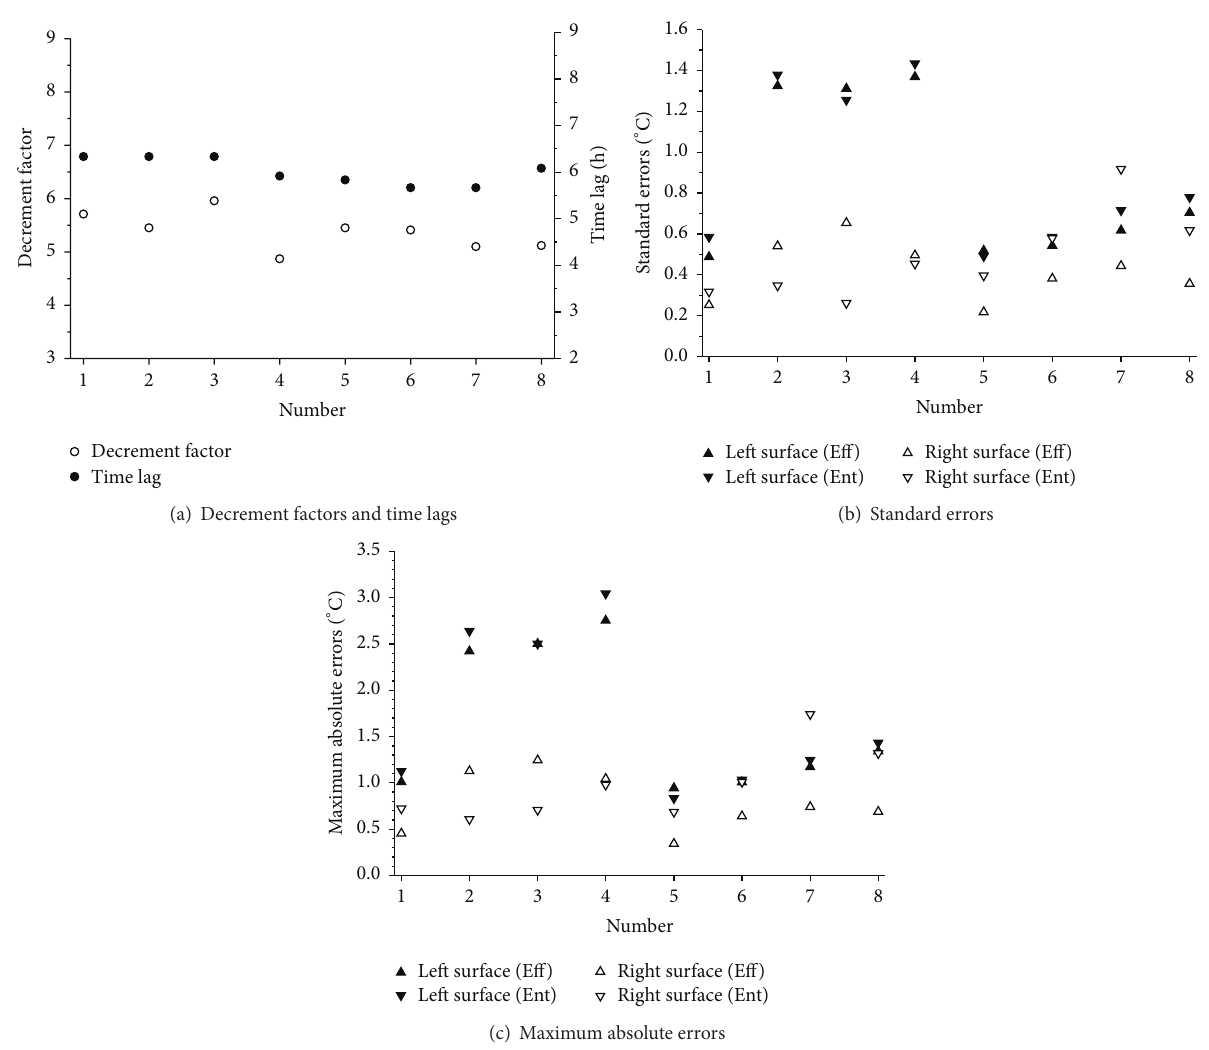
Figure 7: Experimental data of Block 4 wall and calculation